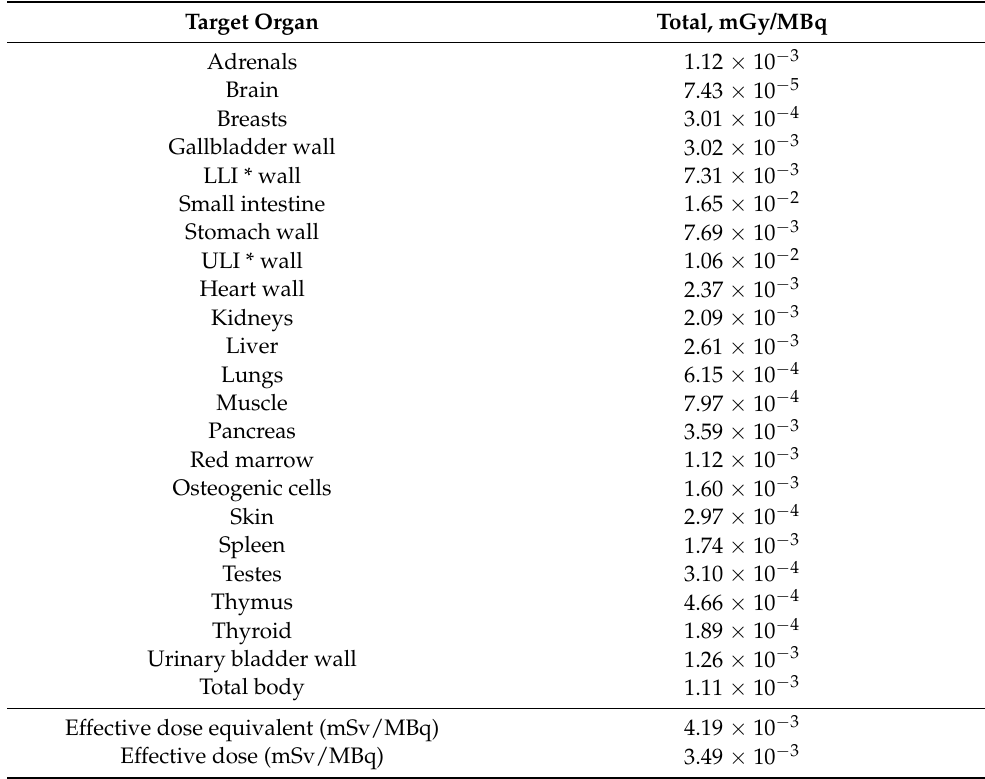
Table 2. Calculated absorbed dose (mGy/MBq) for [ 99m Tc]Tc-maSSS-PEG 2 -RM26 in humans using OLINDA/EXM